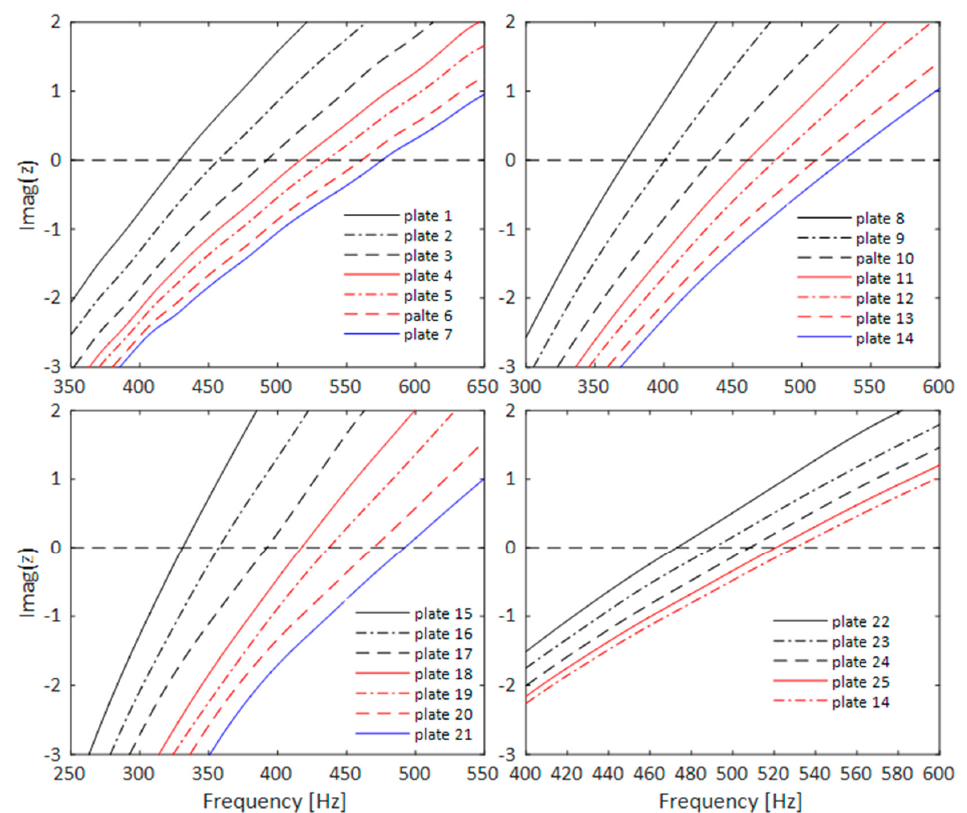
Figure 10. CFD obtained resonance frequencies of perforated plate No. 1–25 absorbers (as listed in Table 1).